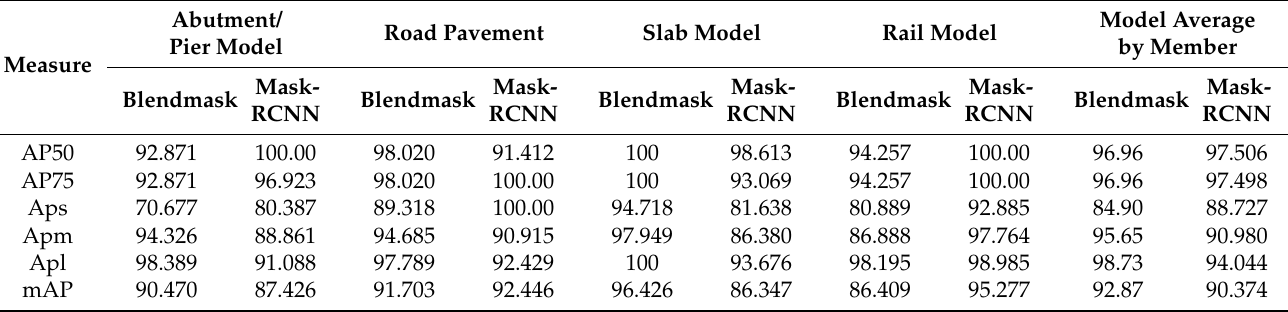
Table 8. Damaged-object-detection performance results for member specific models.